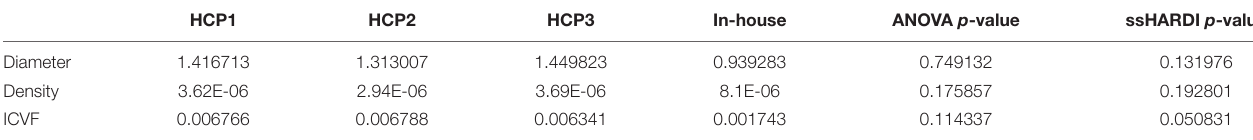
FIGURE 3 | Outcome comparison between single-shell and multi-shell acquisitions. Shown are sample HARDI outcomes based on the ActiveAx model implemented in AMICO using the online Human Connectome Project data (left columns): b = 1000, b = 1000 and 2000, and b = 1000, 2000, and 3000 for the 1-, 2-, and 3-shell, respectively; and using our own diffusion data in this study based on ssHARDI (right column), with b = 1000. All represent in vivo datasets. TABLE 2 | Comparison of variance between measures from different shells and datasets